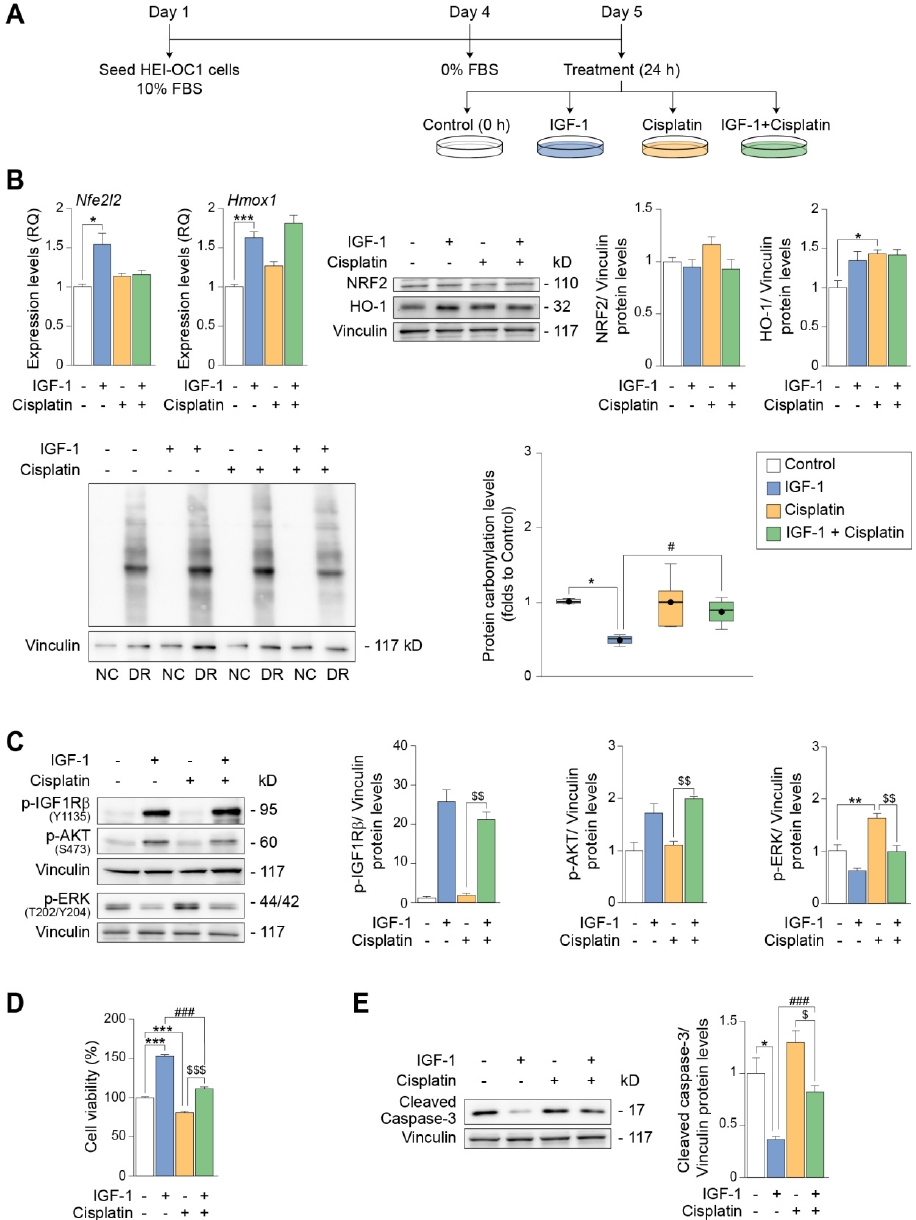
Figure 7. IGF − 1 protects from ototoxic damage induced by long − term exposure to cisplatin. ( A ) HEI − OC1 P cells were cultured in DMEM with 10% FBS for 72 h and then switched to a control medium for 24 h and left untreated (white bars) or treated with IGF − 1 (10 nM) (light blue bars), cisplatin (4 µ g/mL) (yellow bars) or a combination of both (green bars) for 24 h and then lysed for the analysis of target genes and proteins. ( B ) mRNA expression levels of Nfe2l2 and Hmox1 were measured by qPCR (left upper panel), and protein levels of NRF2 and HO − 1 were determined by Western blotting (right upper panel). Gene expression levels from n = 3 independent samples analyzed in triplicate were calculated as 2 − ∆∆ Ct using Rplp0 as an endogenous gene. Representative immunoblots from at least n = 4 independent experiments, using vinculin as a loading control, are shown. Data are expressed as mean ± SEM. Oxidative protein carbonylation levels were measured with the Oxyblot TM Kit (lower panel). Representative immunoblot with carbonylated proteins from n = 4 independent experiments, using vinculin as a loading control, is shown. Non − derivatized extracts